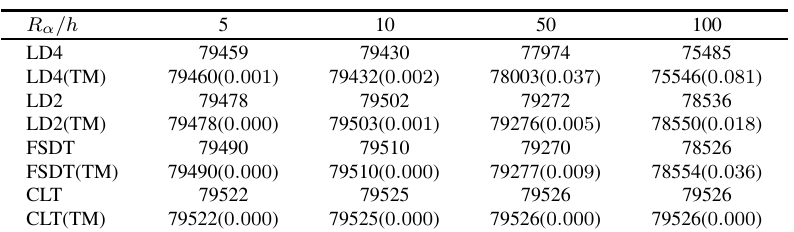
Table 5 Free vibrations of two-layered isotropic shell: fundamental frequency f in Hz for m =